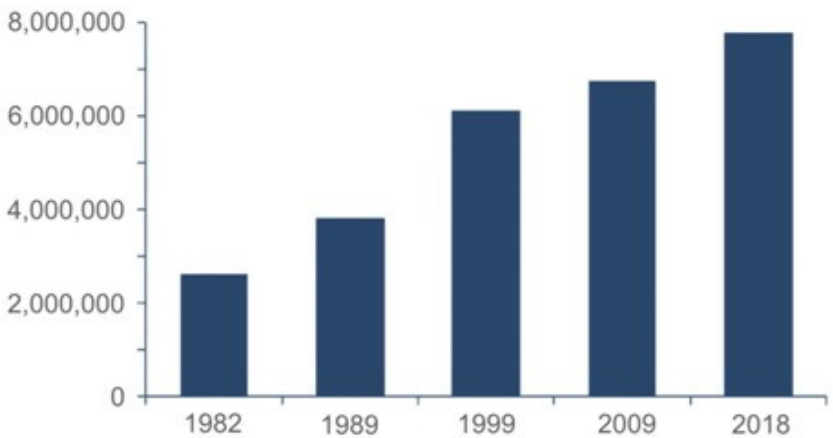
Figure 1. Number of pigs. Source: Idescat and the Pig Observatory of the Department of Agriculture, Livestock and Fisheries (DARP, from the Catalan Government), 2016 Annual report of the pig sector.